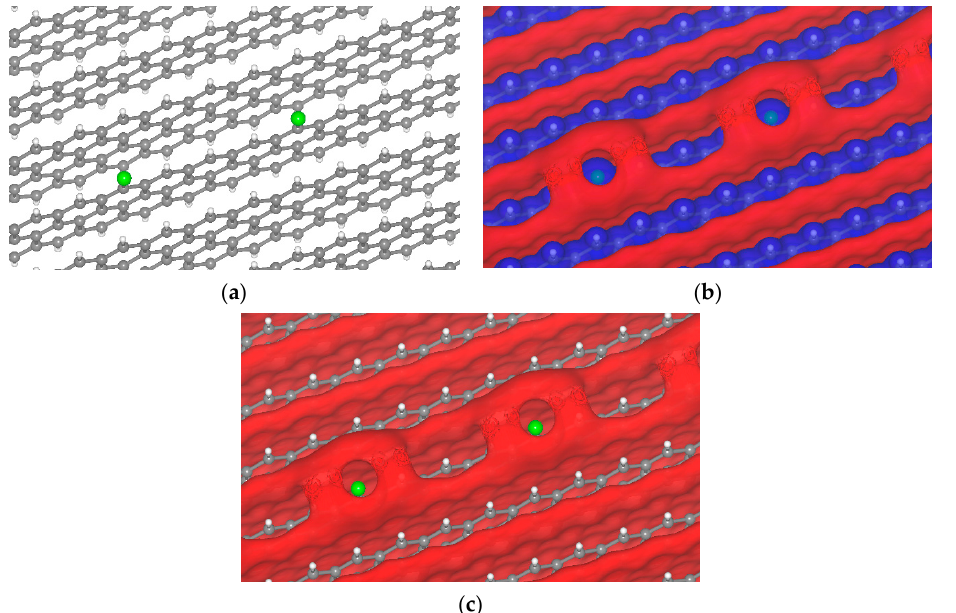
Figure 8. Passivated H-terminated (001) surface. ( a ) Crystal of passivated graphite with chlorine. Isopotential surface of graphite with chlorine atom, separated between negative (red) and positive (blue) regions; ( b ) graphite atomic conformation and isopotential ±2.3 V; and ( c ) graphite atomic conformation and isopotential − 2.3 V.